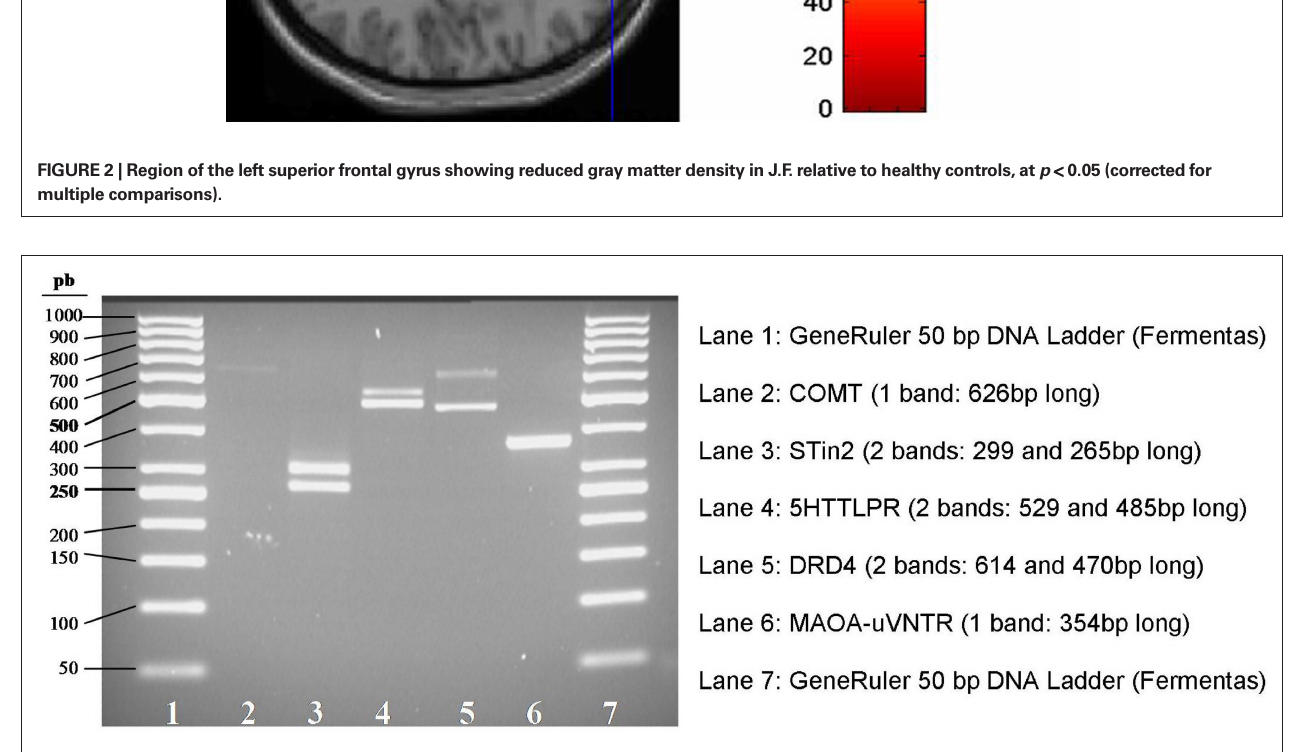
genotype). MAOA-uVNTR (lane 6) shows a single band corresponding to an homozygous genotype. COMT (lane 2) shows a single band, as expected, since it is a SNP. (STin2.10), and 12 (STin2.12) copies of the variable number of tandem repeat (VNTR) region. STin2.12 is supposed to enhance the efficiency of the gene transcription (MacKenzie and Quinn,